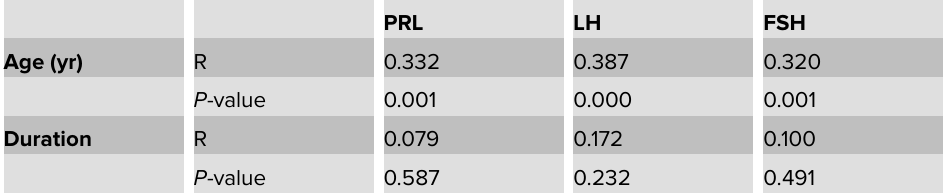
TABLE 3: Correlations of age and duration with PRL, LH and FSH in chronic renal failure.